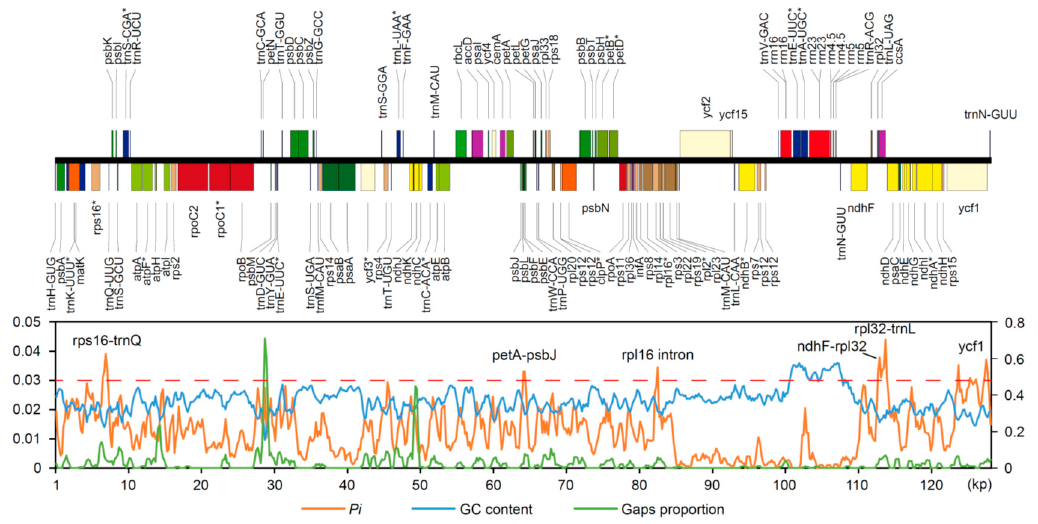
Figure 2. Sliding window analysis showing the nucleotide diversity ( Pi ), GC content, and gap proportion in the five Pogostemon chloroplast genome sequences, using 600 bp windows and a 200 bp step size.